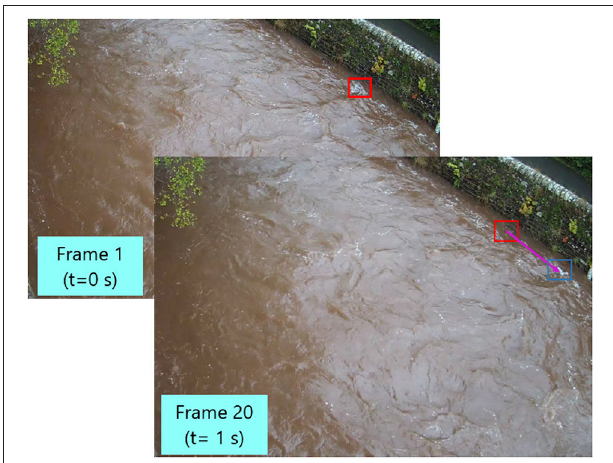
FIGURE 6 | Examples of usable tracers highlighted from a study using a fixed camera with frames exactly 1 s apart.